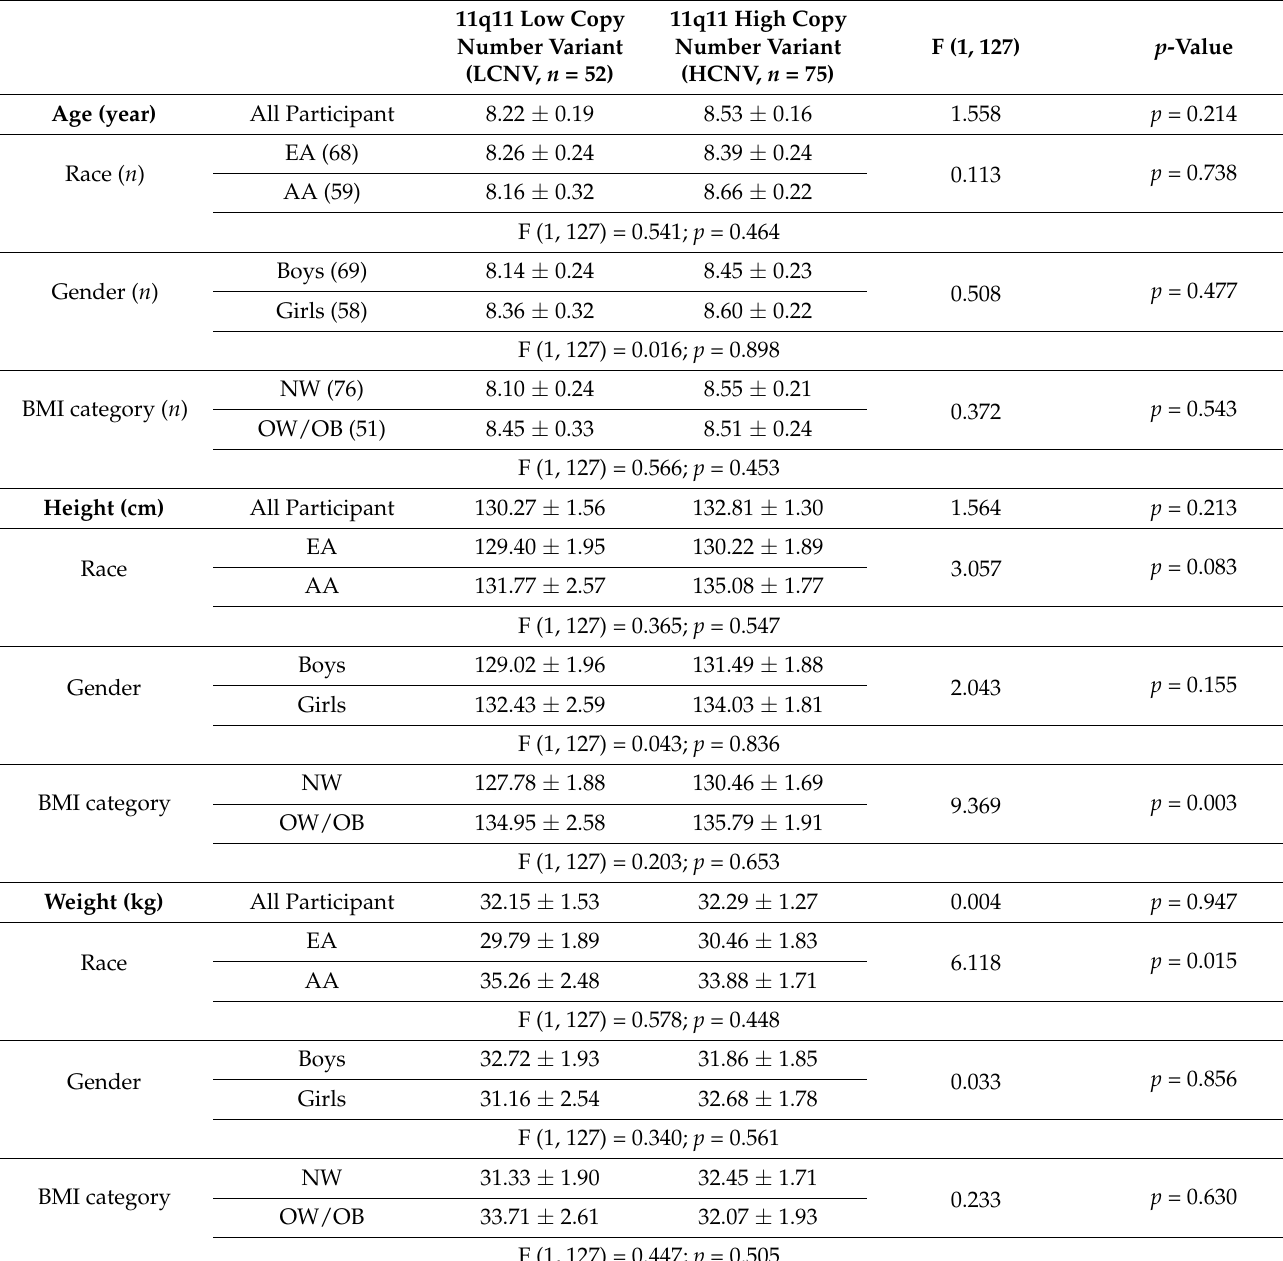
Table 1. General characteristics and 11q11 copy number in the study